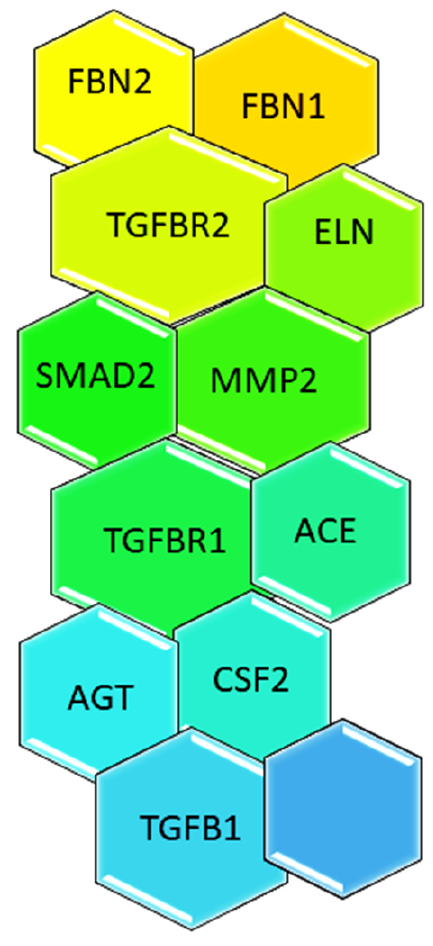
Figure 1. Genes and mutations commonly found in MFS.